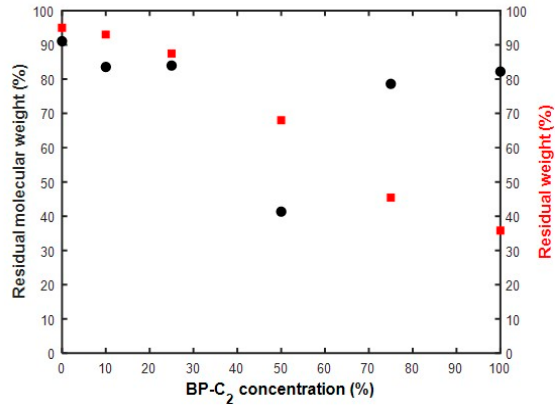
Figure 7. Change in molecular weight ( M w ) (black circles) and the residual sample weight (red squares) after immersion of the polymers having varying BP-C 2 concentrations in PBS buffer with a protease from Bacillus licheniformis for 24 h.